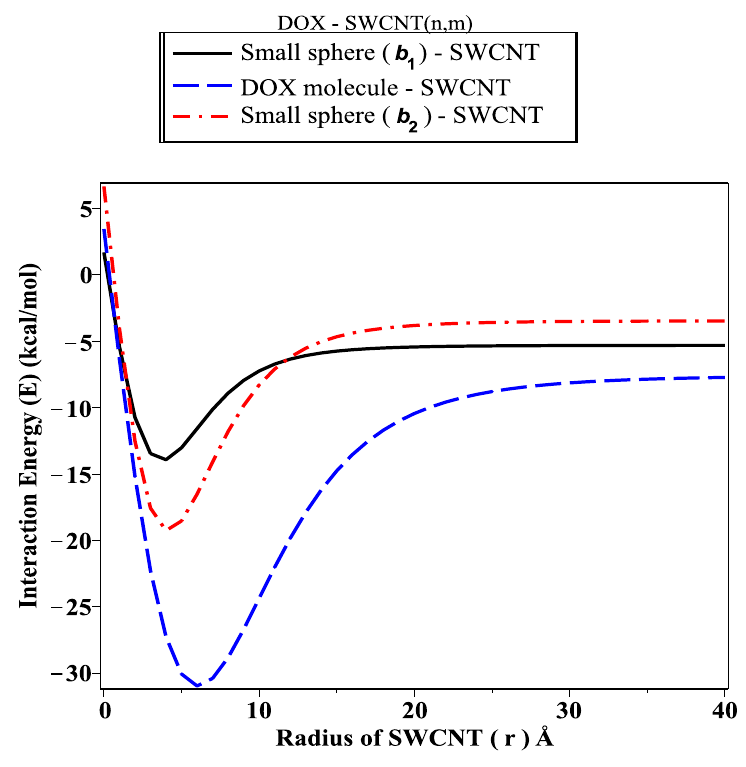
Figure 5. Interaction energy ( E ) arising from DOX molecule as tow-connected spheres, each interact- ing with SWCNT (relationship between the interaction energy and radius of SWCNT r